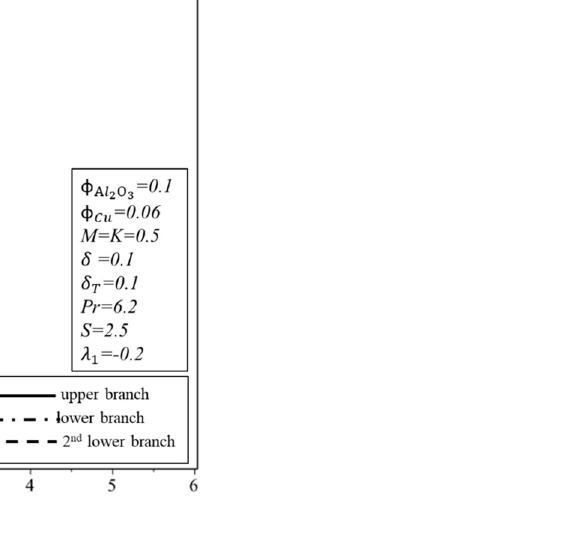
Figure 10. Behavior of f ′ (η) in impact of Rd